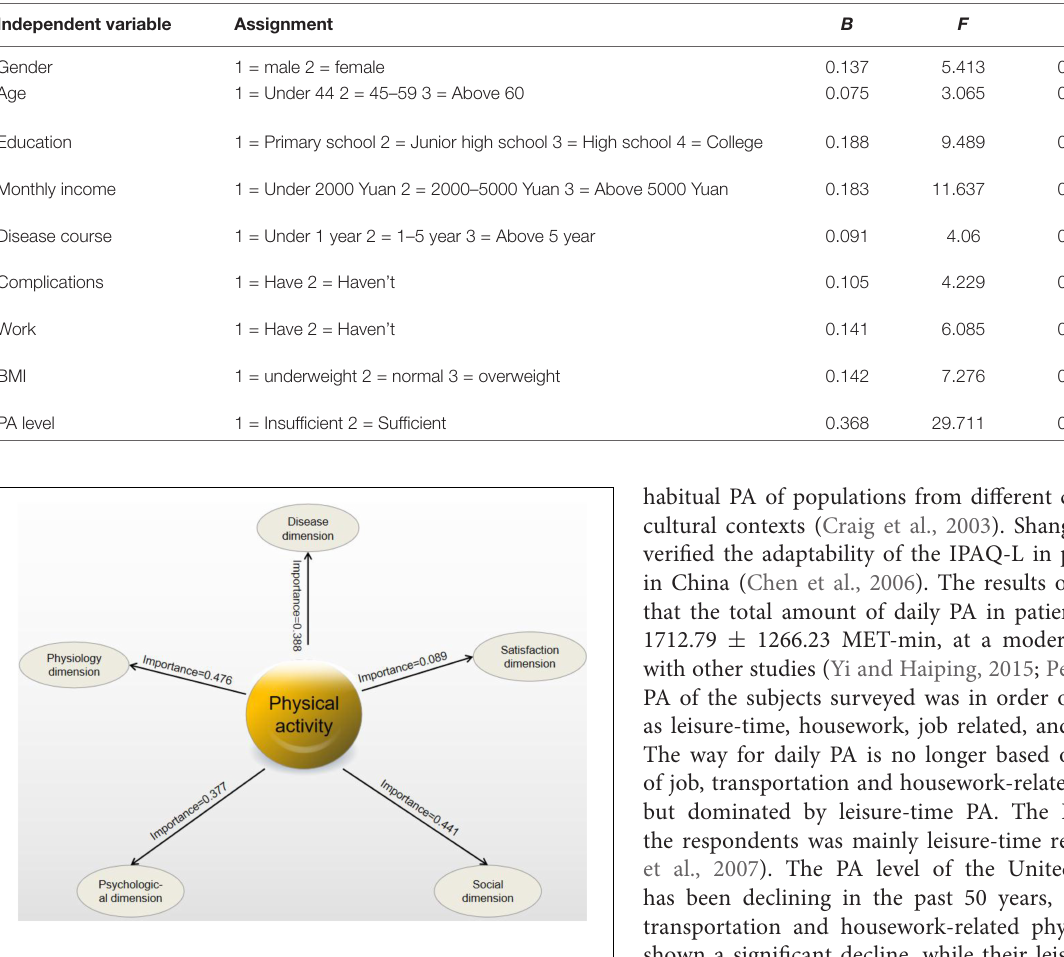
FIGURE 1 | Influence degree of PA on sub-dimensions of